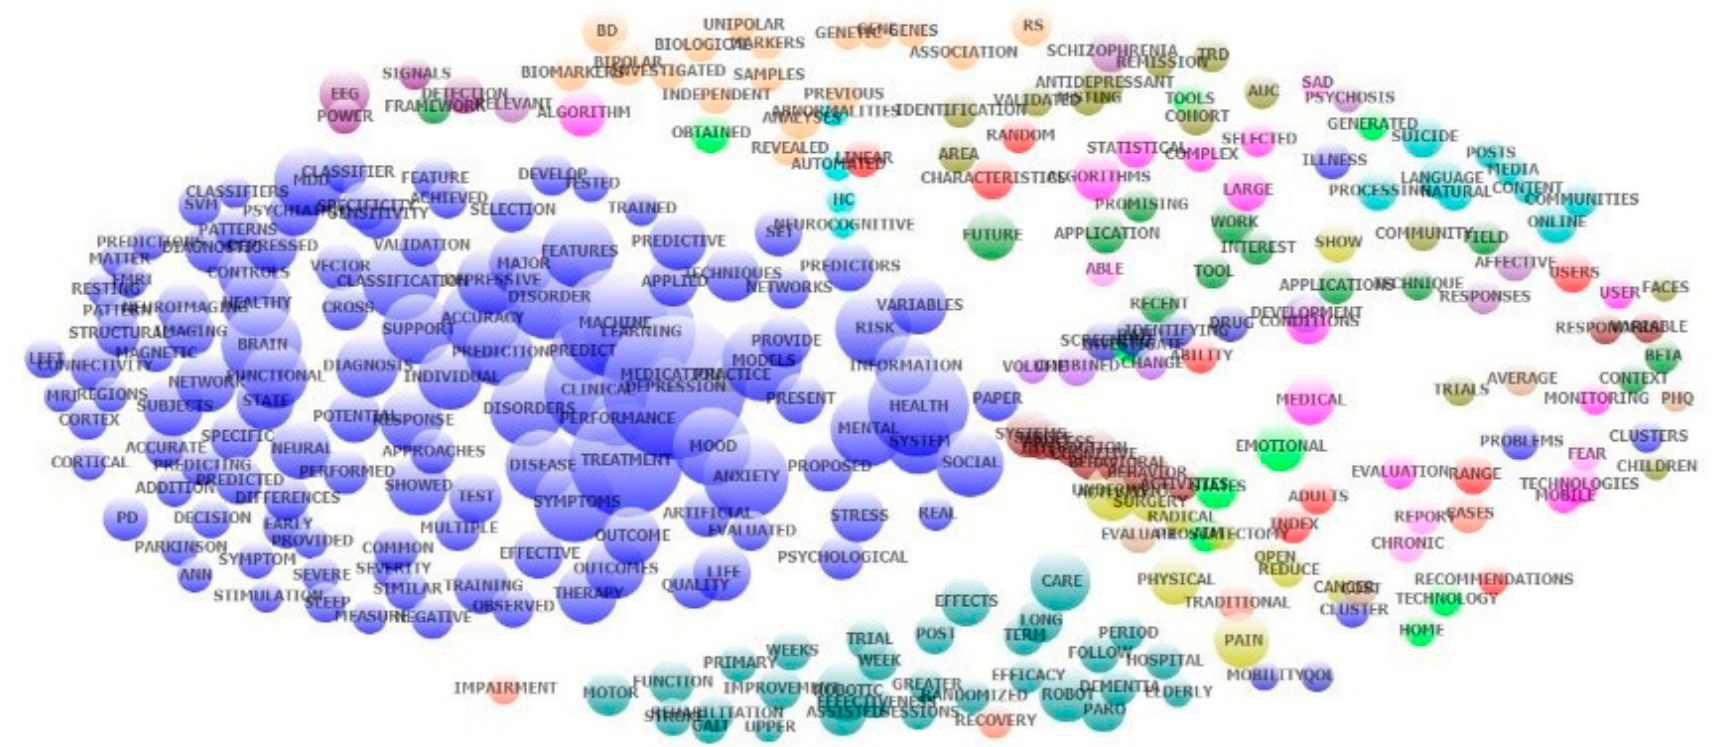
Figure 3. Co-occurrence of the most frequent topics emerged from exploratory factor analysis of abstract content.